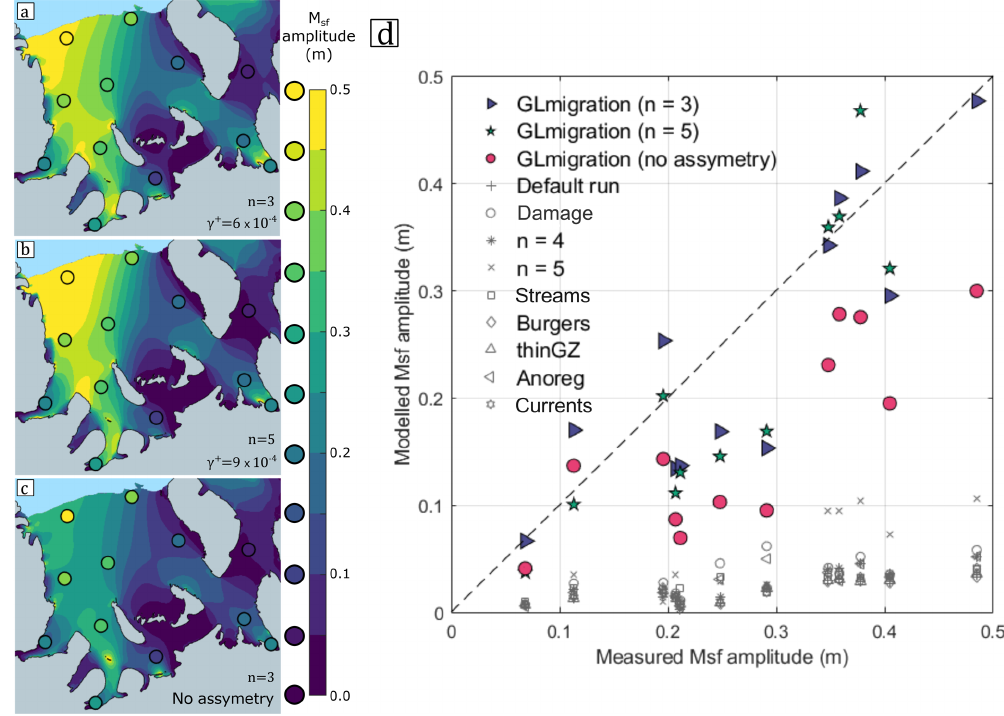
Figure 5. Modelled M sf amplitude on the Ronne Ice Shelf for three variants of the RF_GLmigration model experiment. Panel (a) uses n = 3, γ + = 6 × 10 − 4 and γ − = γ + / 7 . 2, panel (b) uses n = 5, γ + = 9 × 10 − 4 and γ − = γ + / 7 . 2, and, finally, panel (c) uses n = 3 and γ − = γ + = 1 . 05 × 10 − 3 (i.e. no asymmetric grounding line migration). Observed M sf amplitude is indicated by the filled circles using the same colour scale. Panel (d) compares measured and modelled M sf amplitude at each of the marked locations for runs that include the GL migration mechanism (coloured symbols) and those previously presented that do not (grey